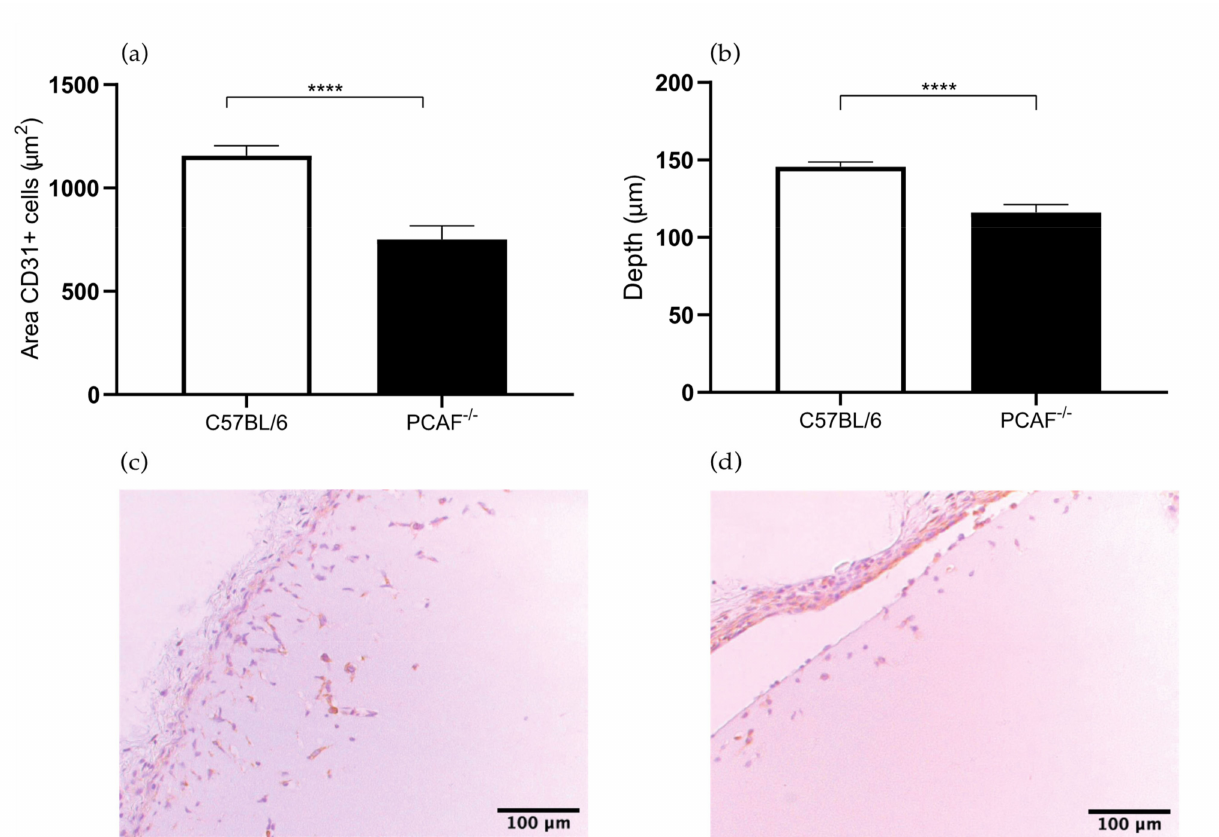
Figure 5. ( a ) Area of CD31+ cells in the subcutaneously injected Matrigel, in p300/CBP-associated factor (PCAF) − / − and wild type C57BL/6 mice. ( b ) Quantification of the depth ( µ m) of ingrowth of CD31 + cells into subcutaneously injected Matrigel, in PCAF − / − and wild type C57BL/6 mice. ( c ) Immunohistochemical staining of paraffin-embedded Matrigel plug of C57BL/6 7 days after Matrigel injection, using anti-CD31 antibodies. ( d ) Immunohistochemical staining of paraffin- embedded Matrigel plug of PCAF − / − mice 7 days after Matrigel injection, using anti-CD31 antibodies. N = 6 mice per group, 2 Matrigel plugs per mouse. Values are presented as the mean SEM. **** p ≤